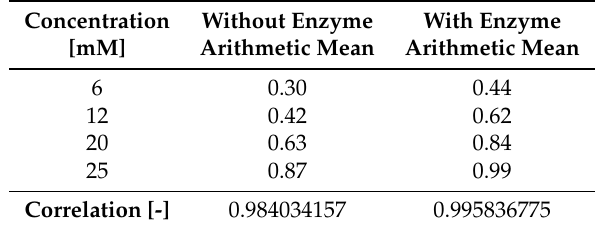
Table 2. Correlation table of Ag/AgCl